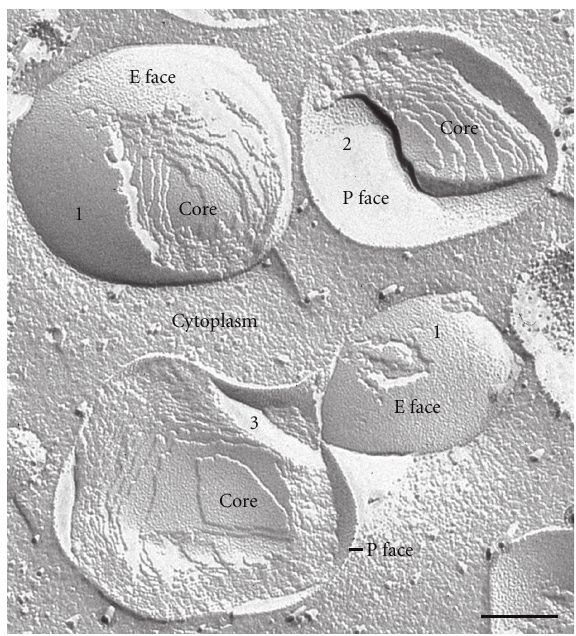
Figure 2: Freeze-fracture of lipid droplets. In freeze-fracture, lipid droplets have a unique smooth appearance enabling their unambiguous discrimination from other organelles. Three di ff erent types of view of the droplet are seen with this technique. (1) The fracture may travel upwards and over the droplet to give a convex fracture, (2) downwards and under to give a concave fracture, (3) or the droplet may be cross-fractured to give what is essentially a cross-section of the core. In concave fracture, the enveloping outer phospholipid monolayer is seen en face (P face); convex fractures give mirror image (complementary, E face) views. In practice, the three alternative fracture paths often occur in combination; concavely fractured droplets often include a portion of the core from small regions of cross-fracture, and some fractures skip along successive layers of the lipid revealing a multilayered onion-like appearance. Bar: 0.2 μ